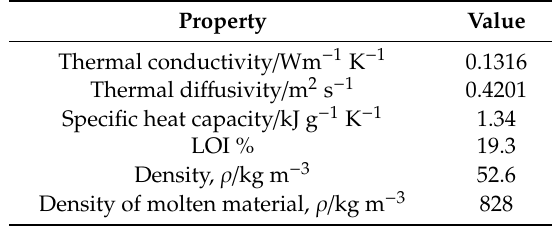
Table 1. Properties of